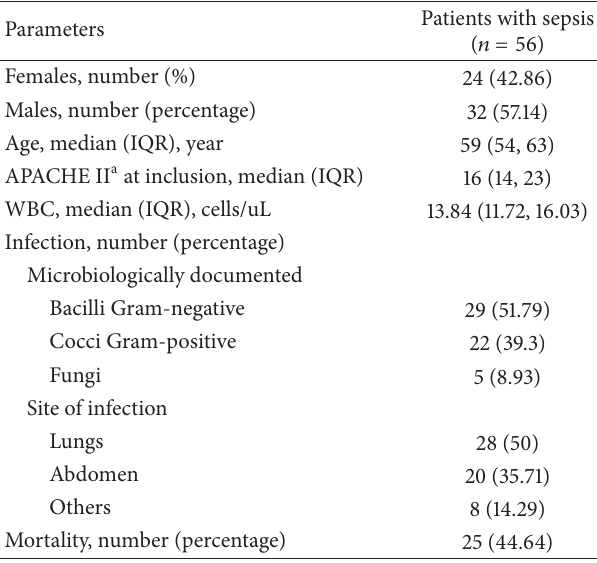
Table 2: Clinical characteristics of the patients with early stage of septic